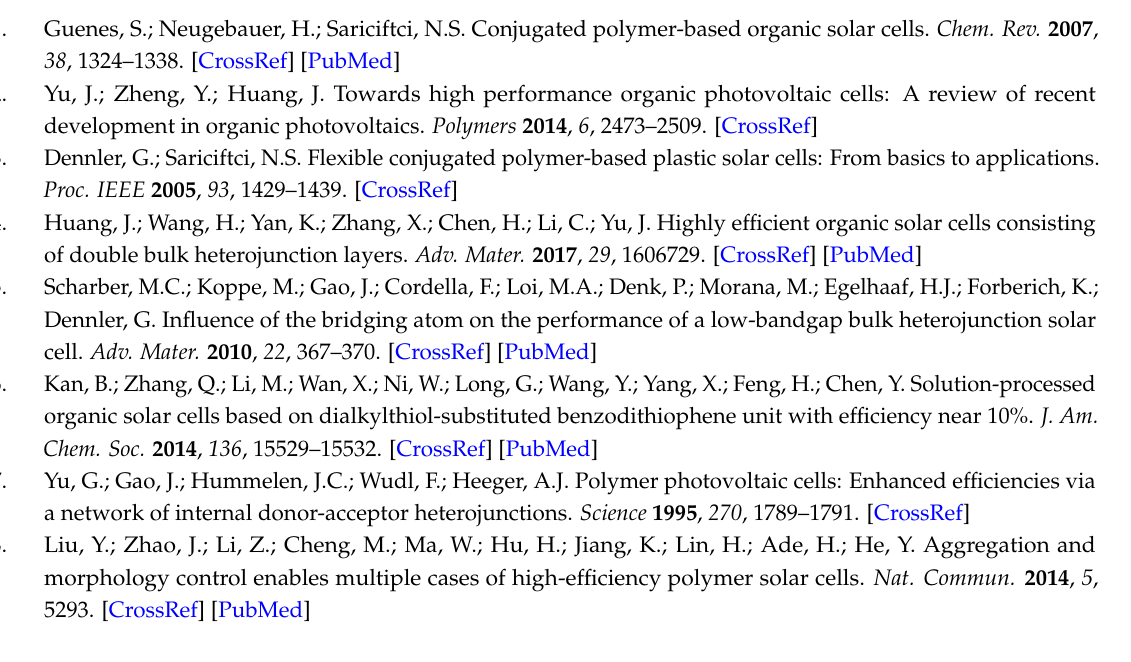
Figure S1: J–V characteristics of OSCs with WO 3 films deposited by vacuum thermal evaporation and spray-coated with different precursor concentration in air, Table S1: RMS of different films using in